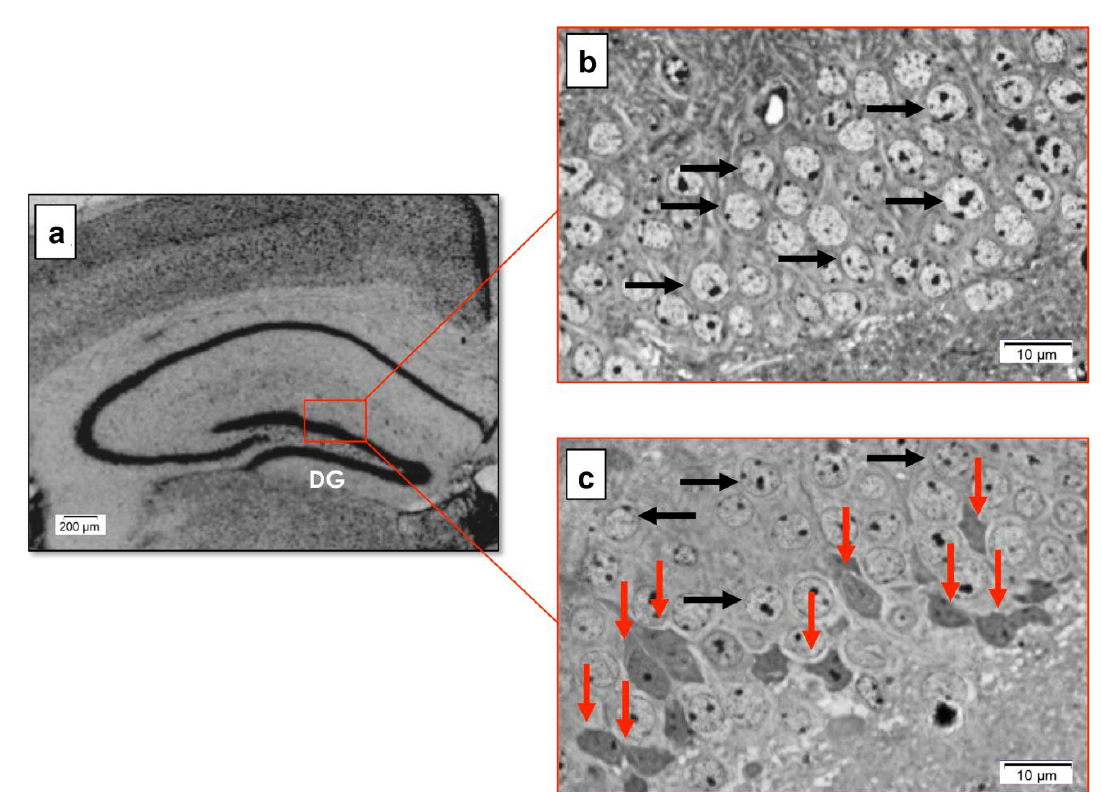
Figure 5. Qualitative morphological analyses of the hippocampal DG region in late symptomatic YAC128 mice and age-matched WT controls. Photomicrography of a coronal hippocampal section from age-matched WT mice ( a ). Representative semithin DG sections from WT ( b ) and YAC128 ( c ) mice. Typical granule cell bodies with a normal shape and regular staining intensity are present in the hippocampal DG of WT and YAC128 mice (black arrows) ( b , c ). Dark granule cells appearing shrunken, with an irregular outline and increased staining intensity (red arrows), can also be noted in the hippocampal DG of YAC128 mice ( c ).